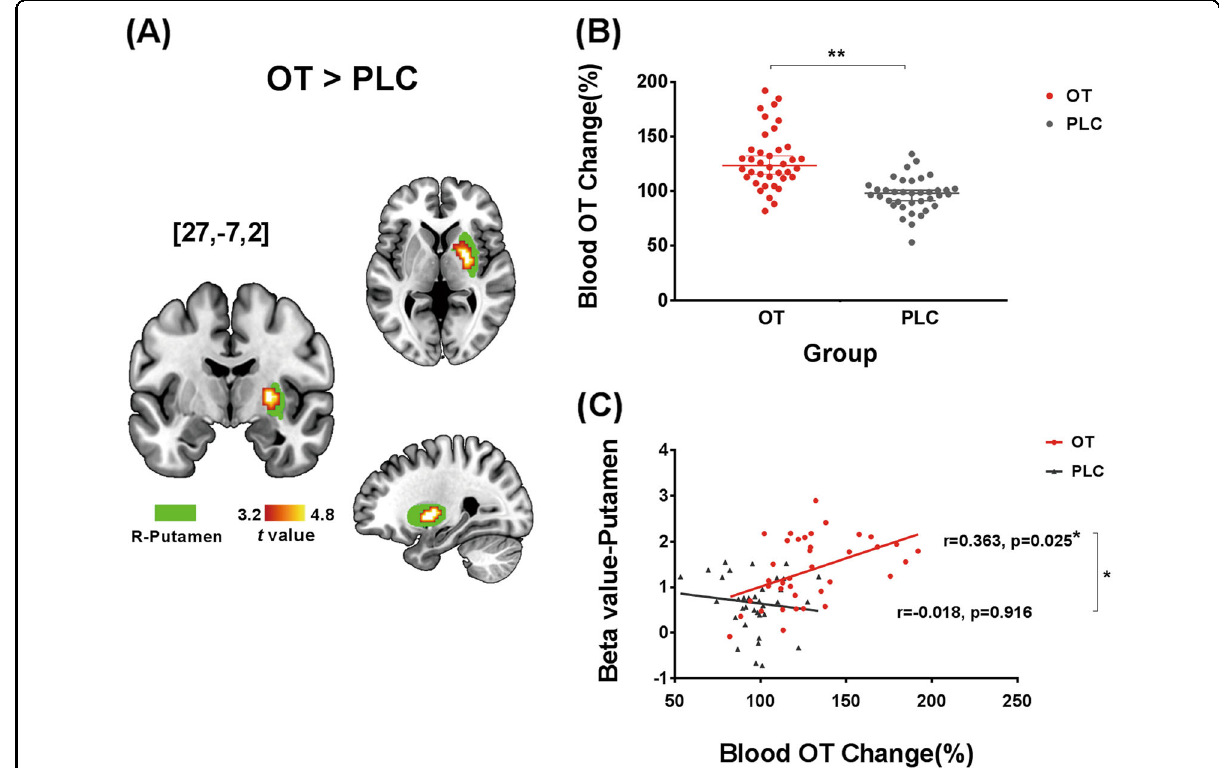
Fig. 1 Main effect of oral oxytocin (OT) on putamen responses and the relationship between OT blood level change and brain activity. A The whole-brain voxel-wise analysis revealed a signi fi cant main effect of treatment in the right putamen re fl ecting that OT increased activation in this region relative to PLC (the cluster is presented in color, displayed at p < 0.05 FWE ); the overlaying mask in green represents the right putamen from the Brainnetome Atlas 51 which was subsequently used as atlas-based independent region of interest (ROI) to extract beta-estimates for further analyses. B Group difference of OT concentration change. C Correlation between putamen activation to all faces and percentage concentration change of plasma